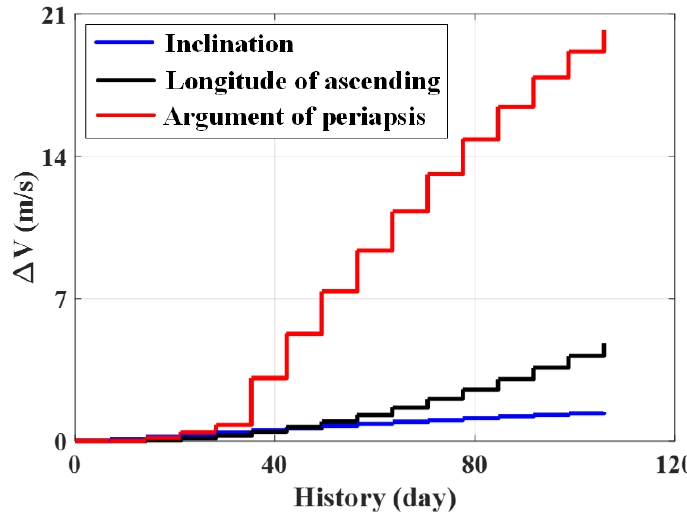
Figure 12. Consumption of the Ganymede-synchronous frozen orbit.